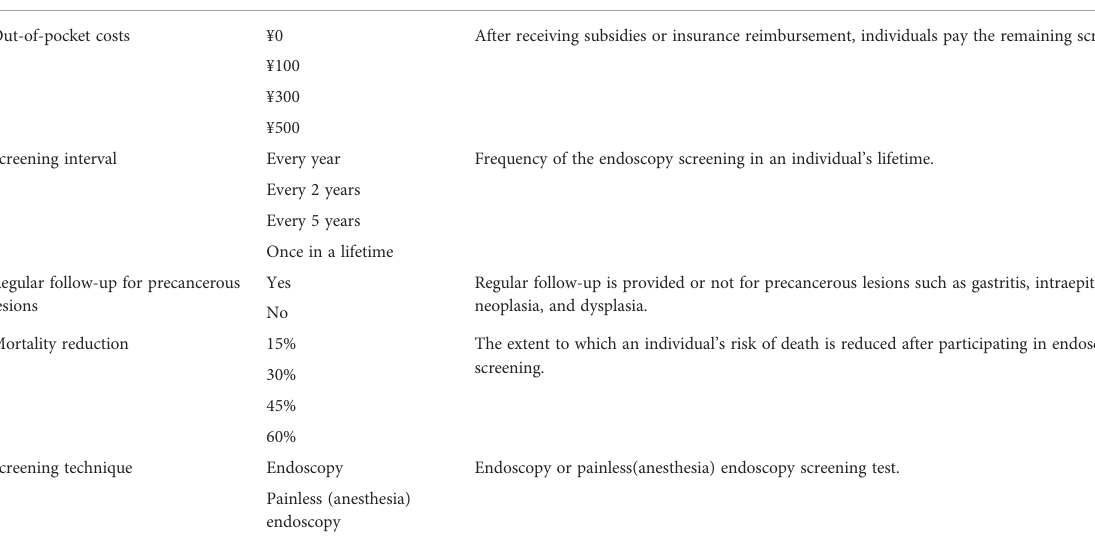
TABLE 1 Attributes and levels for upper gastrointestinal cancer